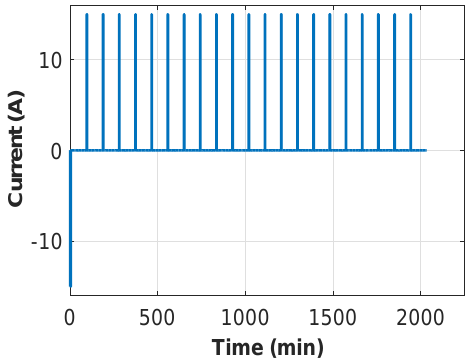
Figure 3. Battery’s charge current profile.